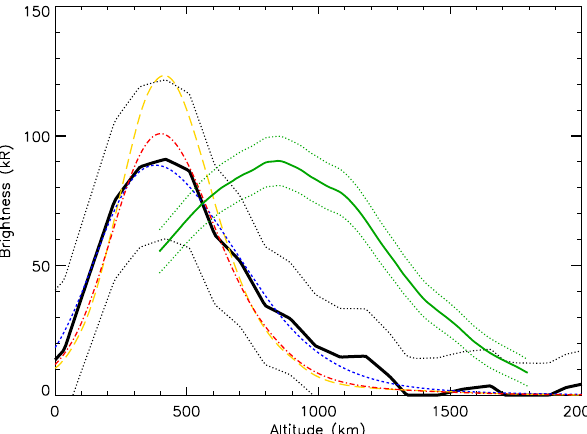
Figure 3. Best fits of a typical observed vertical profile after plane- tary disk subtraction (solid line), using a monoenergetic distribution (long yellow dashes), a Maxwellian distribution (red dash-dotted line), and a kappa distribution (blue short dashed line). The best fit parameters are listed in Table 2. The measurement uncertainty is noted with the dotted black lines. The green curves shows the scaled Io footprint tail vertical profile from Bonfond et al. (2009) and their related uncertainties for comparison. Table 2. Parameters of the best fit curves compared to the summed profile. The mean energy is computed as the ratio of the